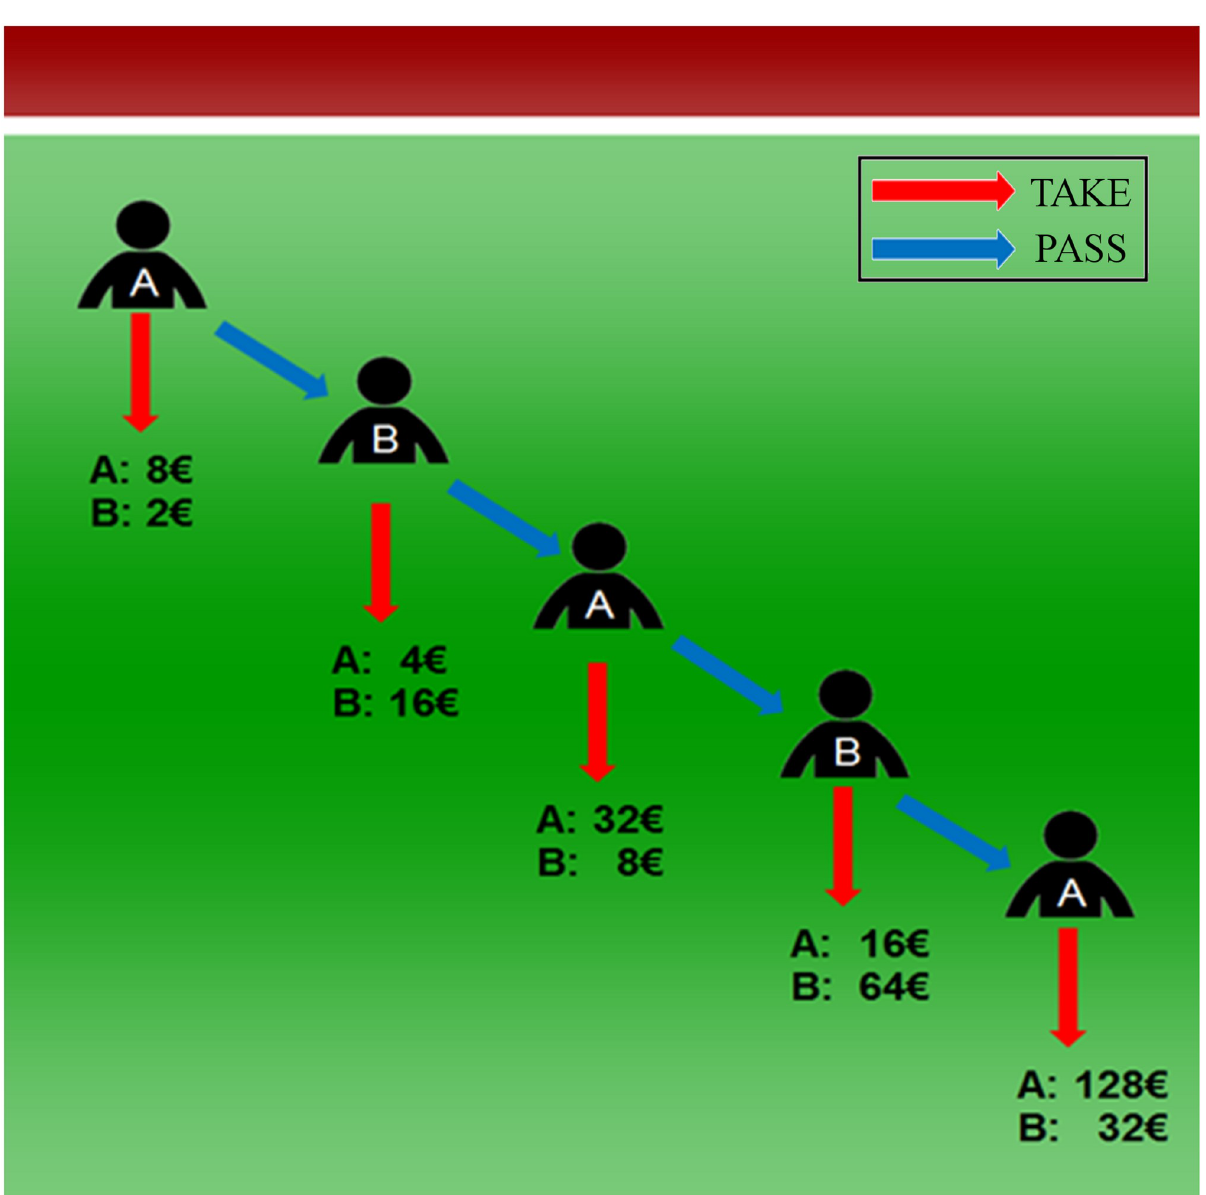
Fig 1. Illustration of the centipede game. Passing doubles joint payoffs and hands over the larger share to the other player.